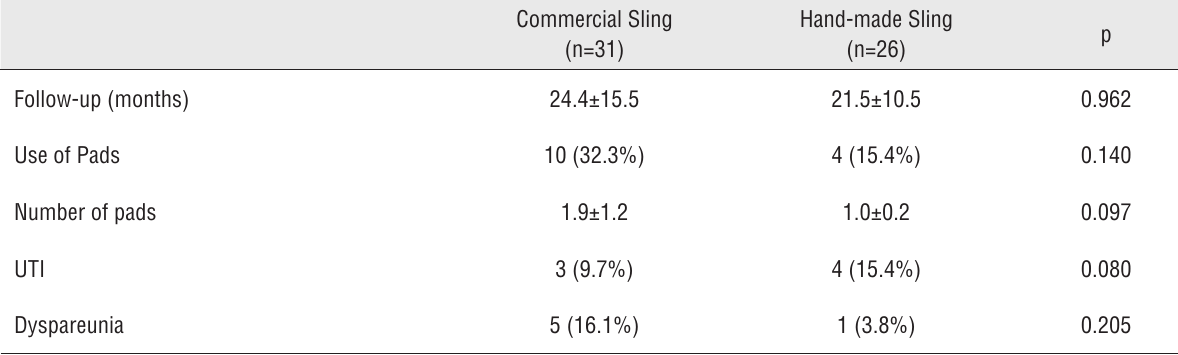
Table 4 - postoperative clinical data. Data expressed in (mean±standard deviation) or n